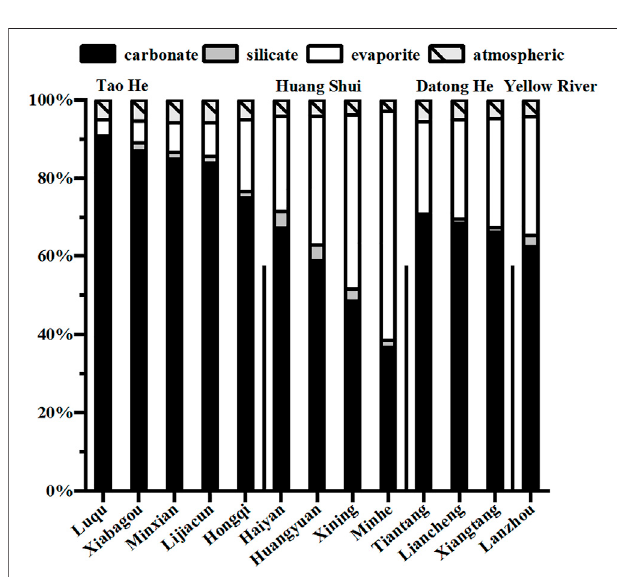
FIGURE 4 | Diagram showing the proportional contributions of the different sources to dissolved cations in summer. Data for contributions of different sources to dissolved cations are in Supplementary Table S3